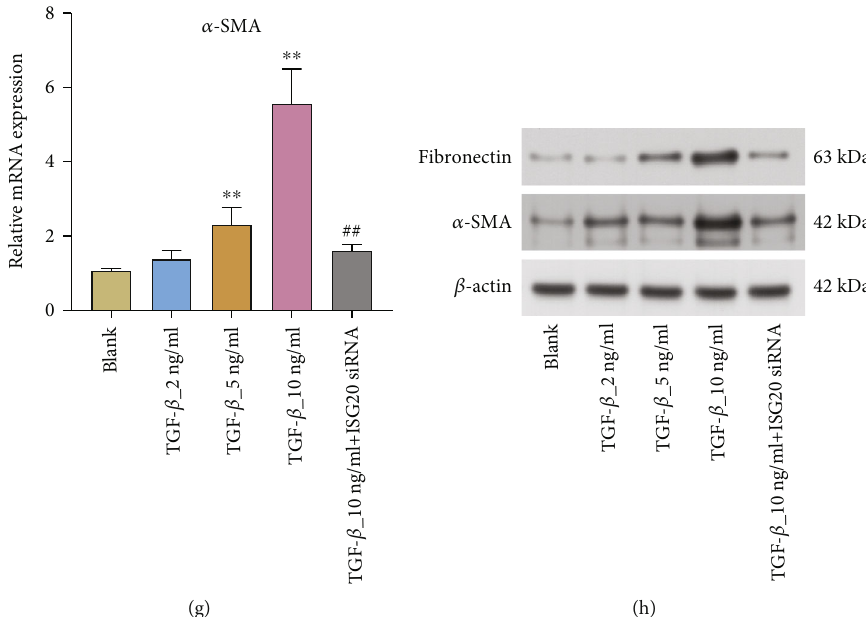
Figure 9: In vitro, suppression of the ISG20 gene signi fi cantly reduced the evolution of renal fi brosis. (a, b) In patients with renal fi brosis, the expression of ISG20 and SERPINA3 was found to be upregulated in a unique manner. (c, d) For 48 hours, HK-2 cells were exposed to concentrations of 2, 5, or 10ng/ml TGF-1. qRT-PCR was used to detect the expressions of ISG20 and SERPINA3 in HK-2 cells. (e) ISG20 siRNA was transfected into HK-2 cells. Subsequently, using RT-PCR, we discovered that ISG20 was expressed in HK-2 cells. (f, g) RT-PCR was used to fi nd out how much mRNA fi bronectin and α -SMA were making in HK-2 cells. (h) The protein expressions of fi bronectin and α -SMA in HK-2 cells were determined by western